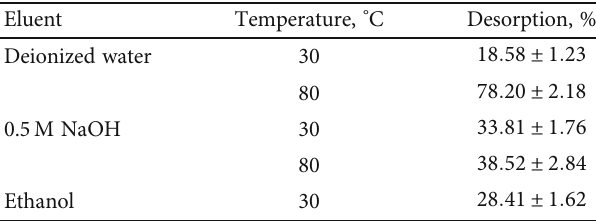
Table 4: Desorption of IA from CSK6 adsorbent using di ff erent